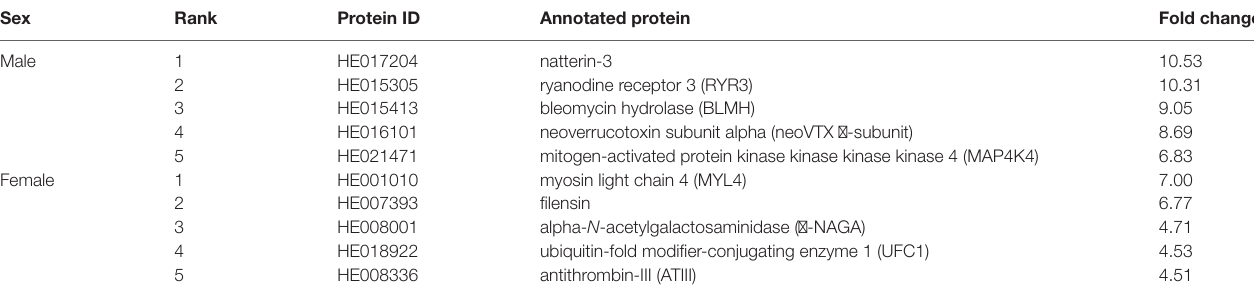
TABLE 3 | Top 5 AHTP-derived DEPs with the highest fold changes in female or male samples.